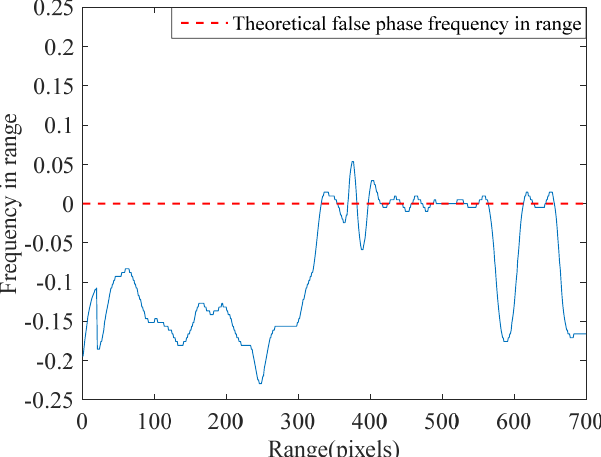
Figure 5. Range frequency of the interferometric phase in Figure 2b.